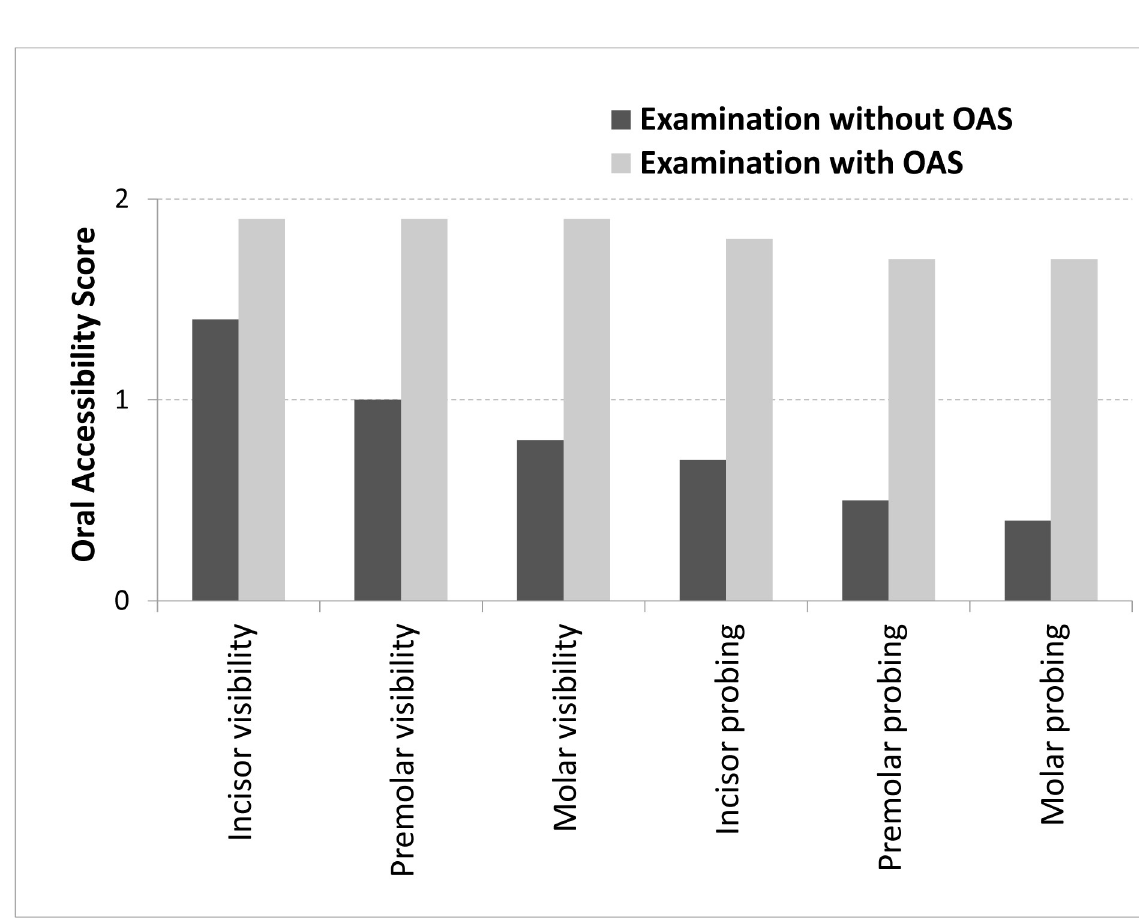
Fig 3. Average visibility or Probe-ability oral accessibility scores for the incisor/canine, premolar, and molar tooth sectors without and with the spatula ( n = 201). The score for each tooth sector was 0 if both the left and right sides of the tooth sector were not visible/probe-able; 1 if only the left or right side of the tooth sector was visible/probe-able; and 2 if both the left and right sides of the tooth sector were visible/probe- able. For all tooth sectors, the spatula significantly increased the average Visibility/Probe-ability Oral Accessibility Score (all p < 0.05), as determined by Wilcoxon’s signed ranks test. OAS, Oral Accessibility